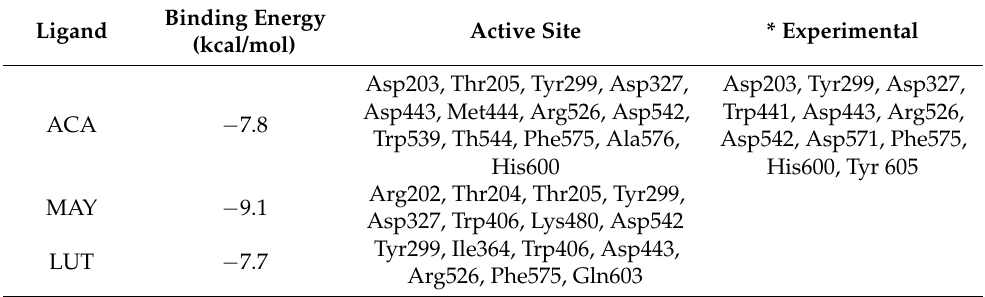
Table 1. Analysis of molecular interactions between the maltase-glucoamylase (NtMGAM PDB ID: 2MQJ) and acarbose (ACA), maysin (MAY), and luteolin (LUT) provided by molecular docking